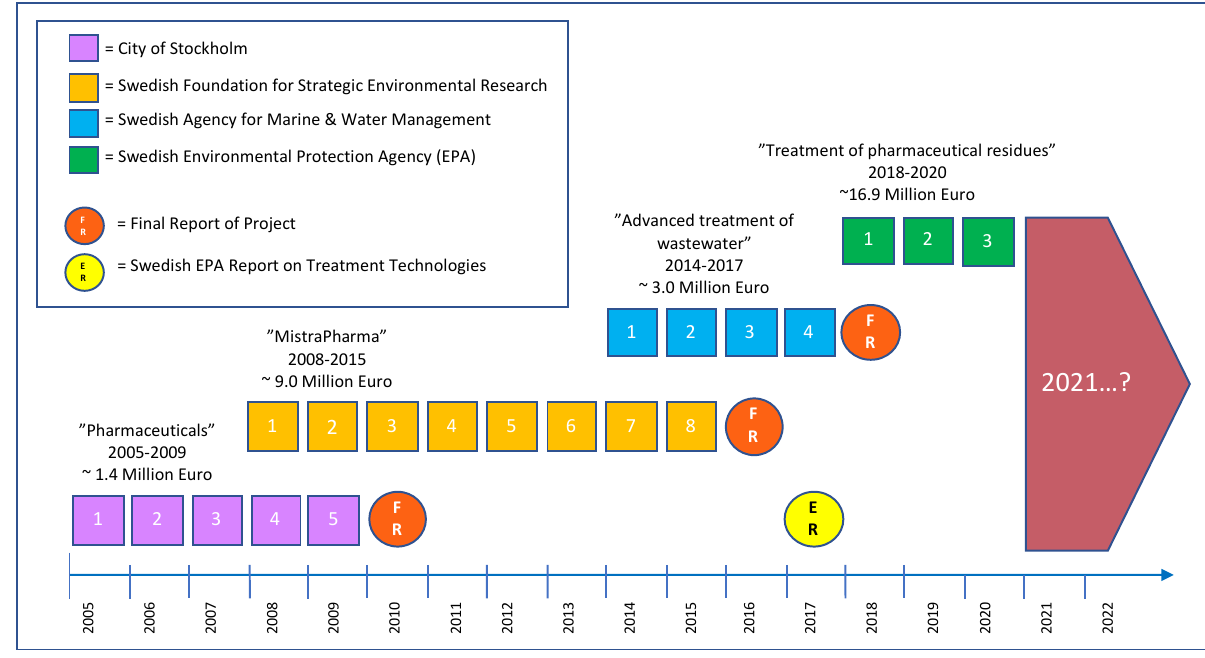
Figure 1. Example of major research funding made available in Sweden for 2005–2020 in relation to pharmaceuticals in the environment (PIE) and their removal from wastewater in WWTPs.